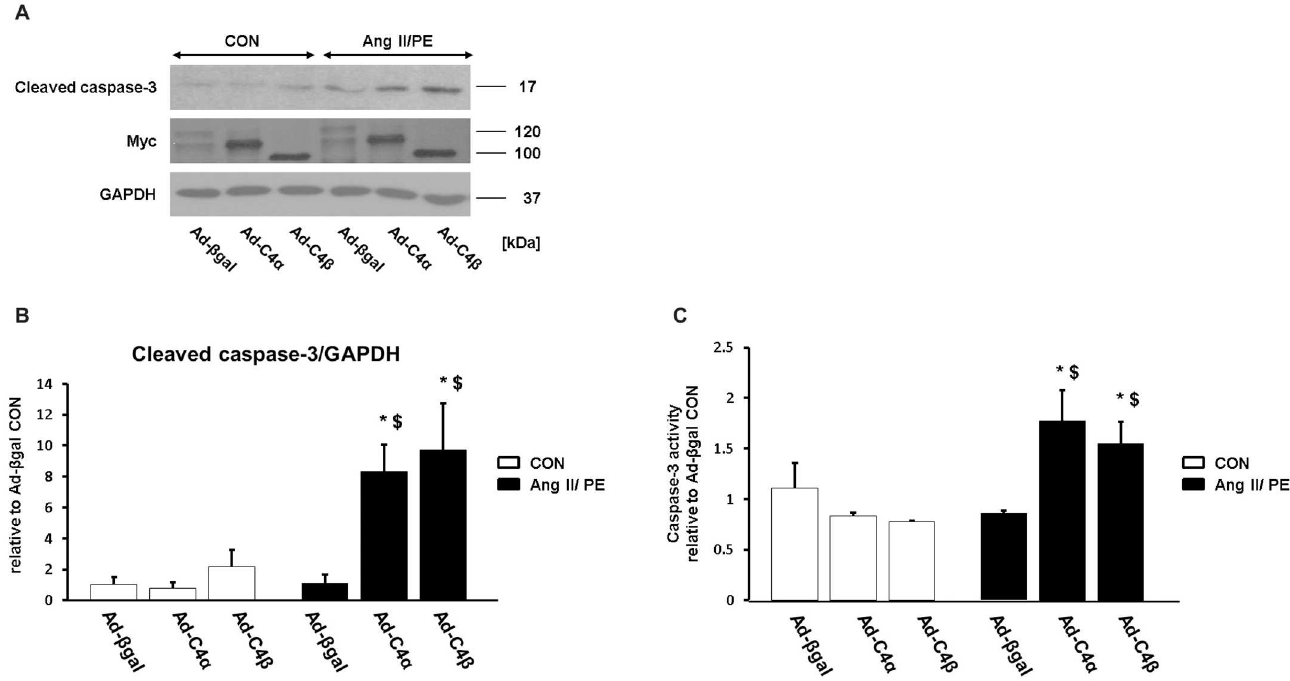
Fig 9. Increased apoptotic rate in cardiomyocytesoverexpressing TRPC4 α or TRPC4 β . A, Cleavedcaspase-3 expressionlevels were detected in neonatalrat cardiomyocytes (NRCs) after Ang II/PE or vehicle(CON) treatment. GAPDH: loadingcontrol. Myc: detectionof TRPC4 α and TRPC4 β . Shown are representative immunoblots from three independentexperiments. B, Average quantified values of cleaved caspase-3 expression levels relative to Ad- β galCON for n = 3 experiments. C, Capase-3activity was comparedbetweenAd- β gal,Ad-TRPC4 α and Ad-TRPC4 β in NRCs. Caspase-3assays were performed in duplicateand averagevalues were quantifiedrelative to Ad- β galCON; n = 3 experiments.